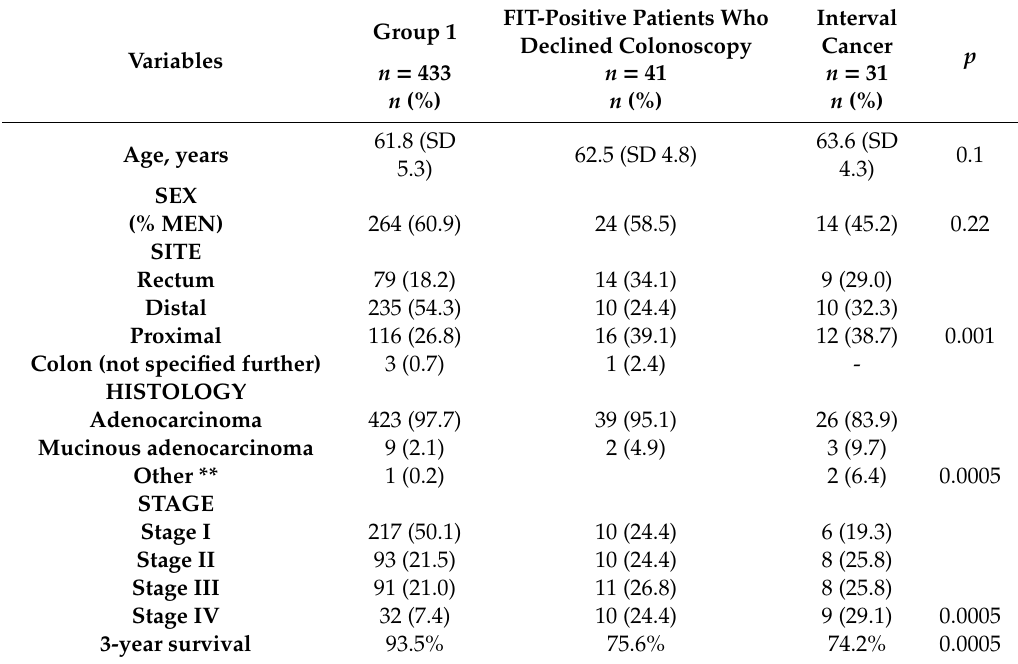
Table 4. Clinical characteristics of patients diagnosed with colorectal